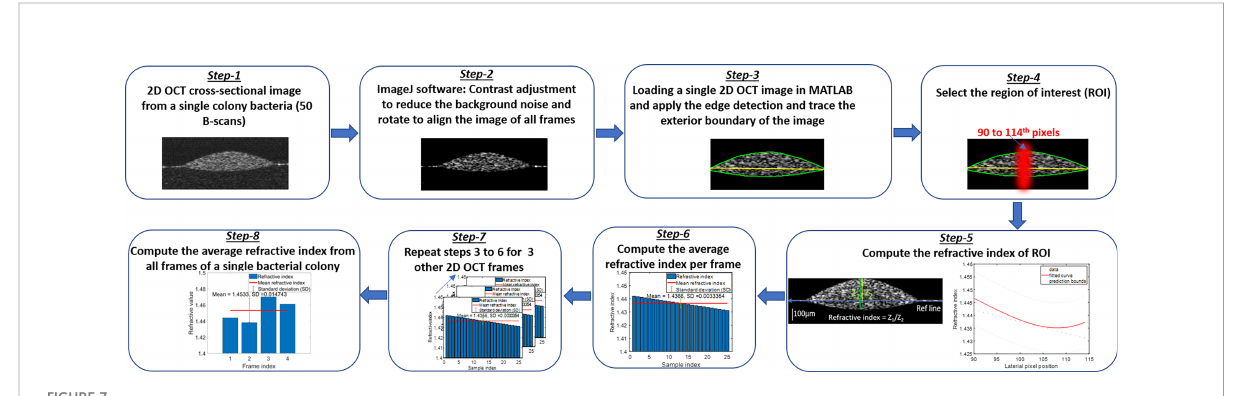
FIGURE 7 Flow diagram of the refractive index calculation